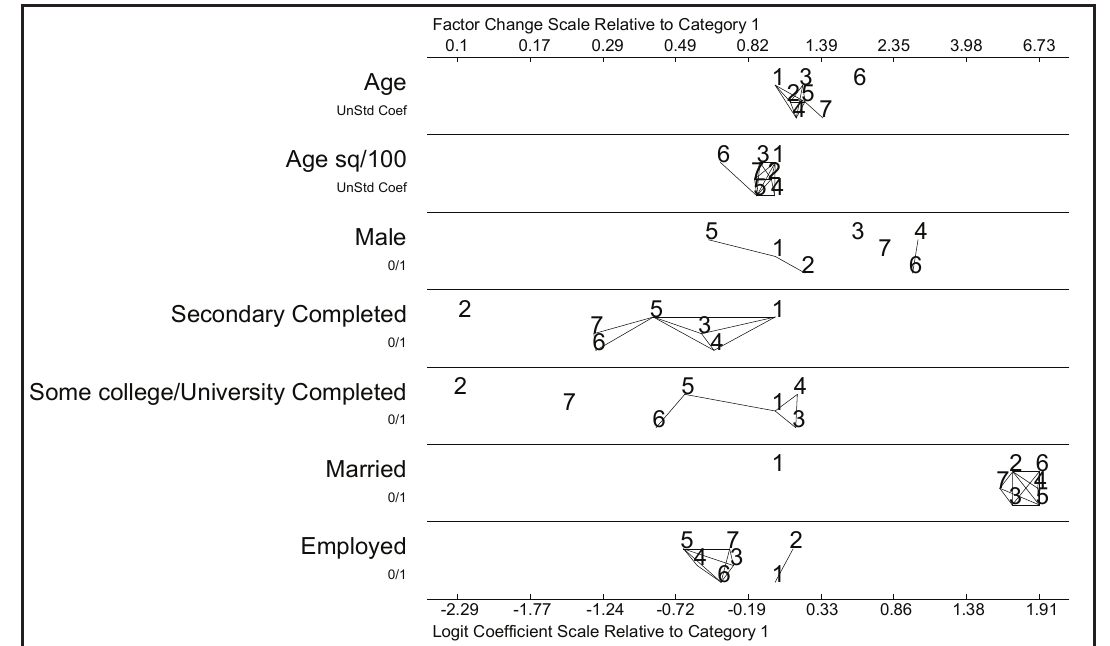
Factor Change Scale Relative to Category